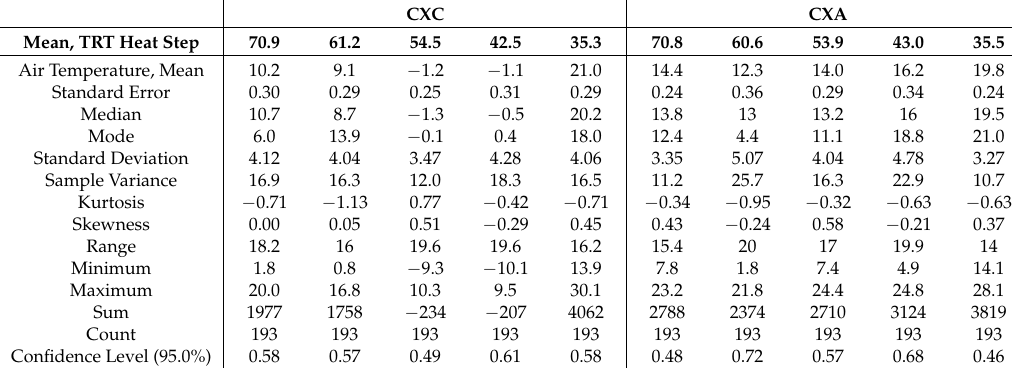
Table 2. Air temperature descriptive statistics during